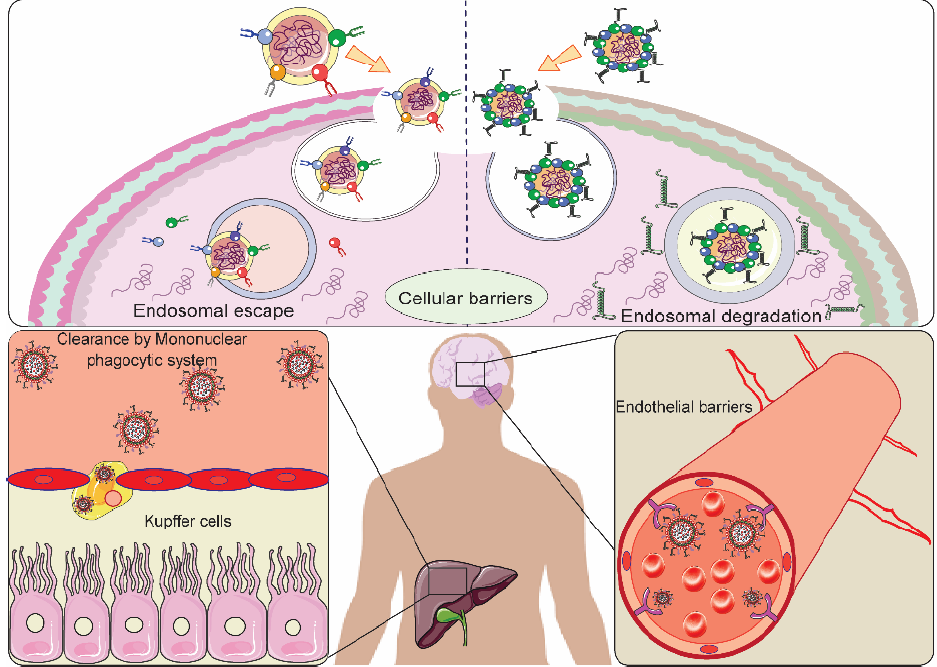
Figure 1. Graphic depiction of major barriers obstructing the nano delivery system (NDS), such as the endosomal – lysosomal system, clearance of NDS via the mononuclear phagocytic system, and endothelial barrier acting in the event of extravasation of NDS in cancer.